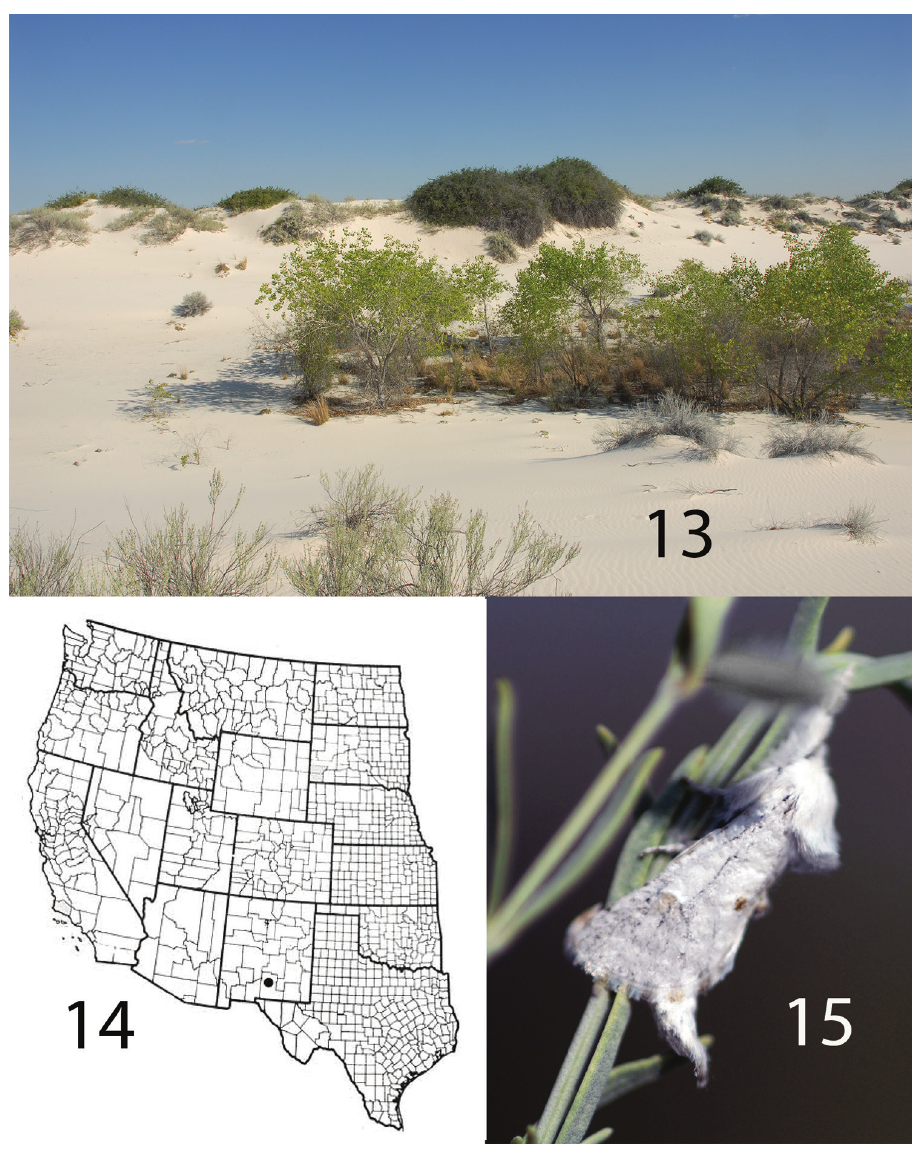
Figures 13–15. Givira delindae 13 type locality 14 distribution 15 Adult resting on a branch of frosted mint ( Poliomintha incana (Torr.) A. Gray (Lamiaceae)), a common shrub in the dunes. tween A and A of the forewing (near the tornus in G. delindae ), 2) veins R and M 1 2 the hindwing stalked, and 3) one pair of apical